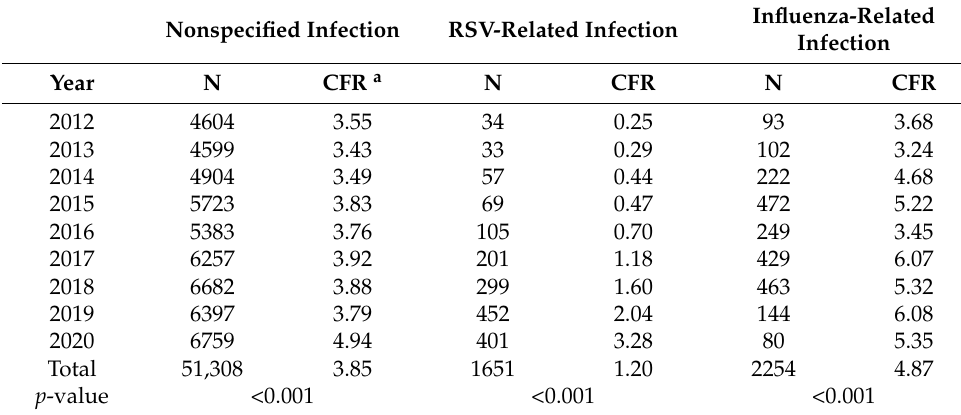
Table 4. In-hospital case fatality rate in the general population in Spain by diagnostic group and year between 2012 and